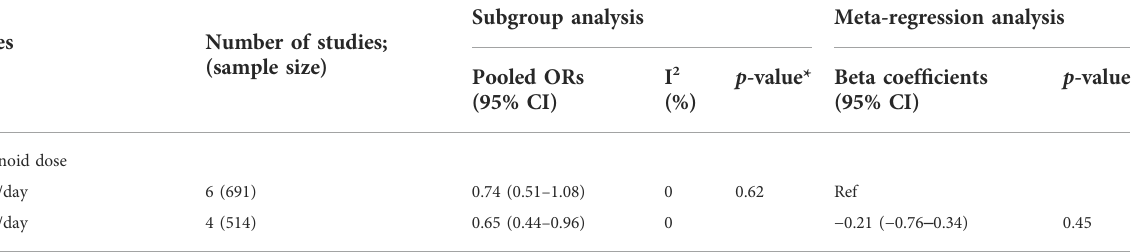
TABLE 3 ( Continued ) Subgroup and meta-regression analyses of the risk of central nervous system depression and gastrointestinal disorders in randomized controlled